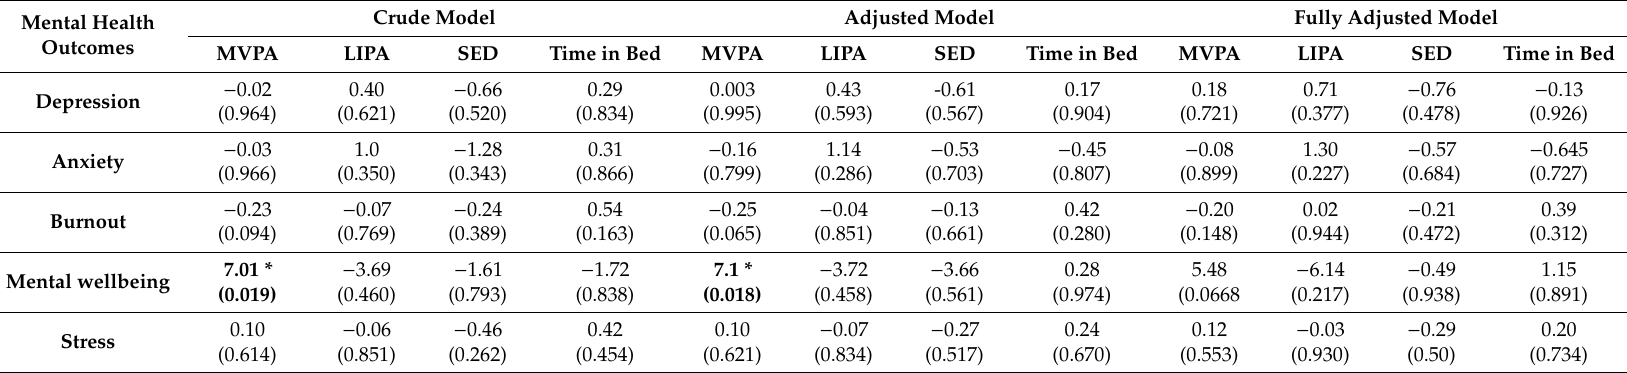
Table 3. Results from linear regression models assessing associations between time spent in each movement-related behavior (time in bed, SED, LIPA, MVPA), relative to the remaining behaviors, and mental health